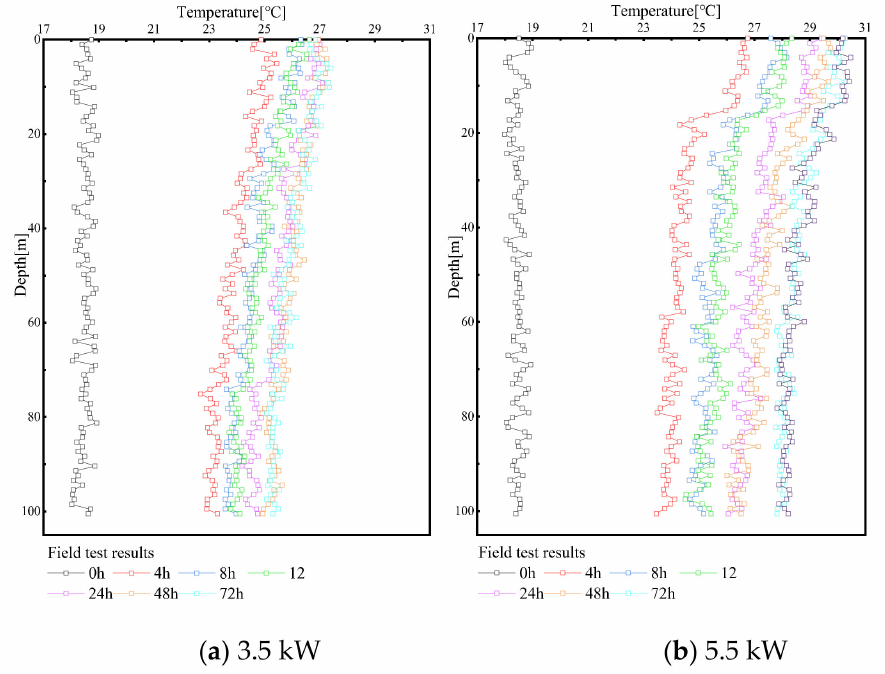
Figure 10. Variation of the temperature of #1 pile inlet pipe with time under different heating